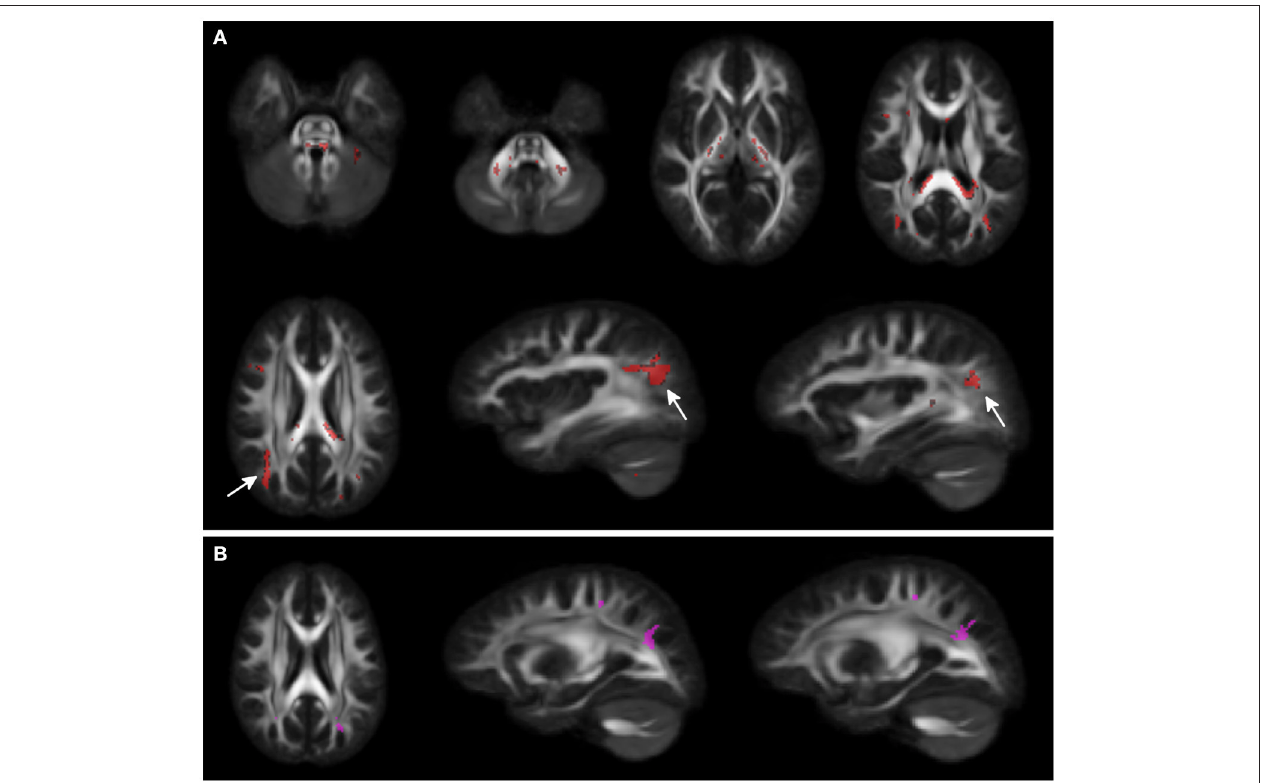
FIGURE 1 | Voxel-wise Fractional anisotropy (FA) differences between Williams Syndrome (WS) and healthy controls (HC). Panel (A) (First 2 rows) shows in red the areas where FA values are lower in WS patients compared to the HCs. Arrows point at bilateral parieto-occipital clusters. Panel (B) shows the small cluster of higher FA in the left hemisphere (arrowheads) for the WS group compared to the HCs. Significance level is set at p < 0.05 corrected for multiple comparisons.